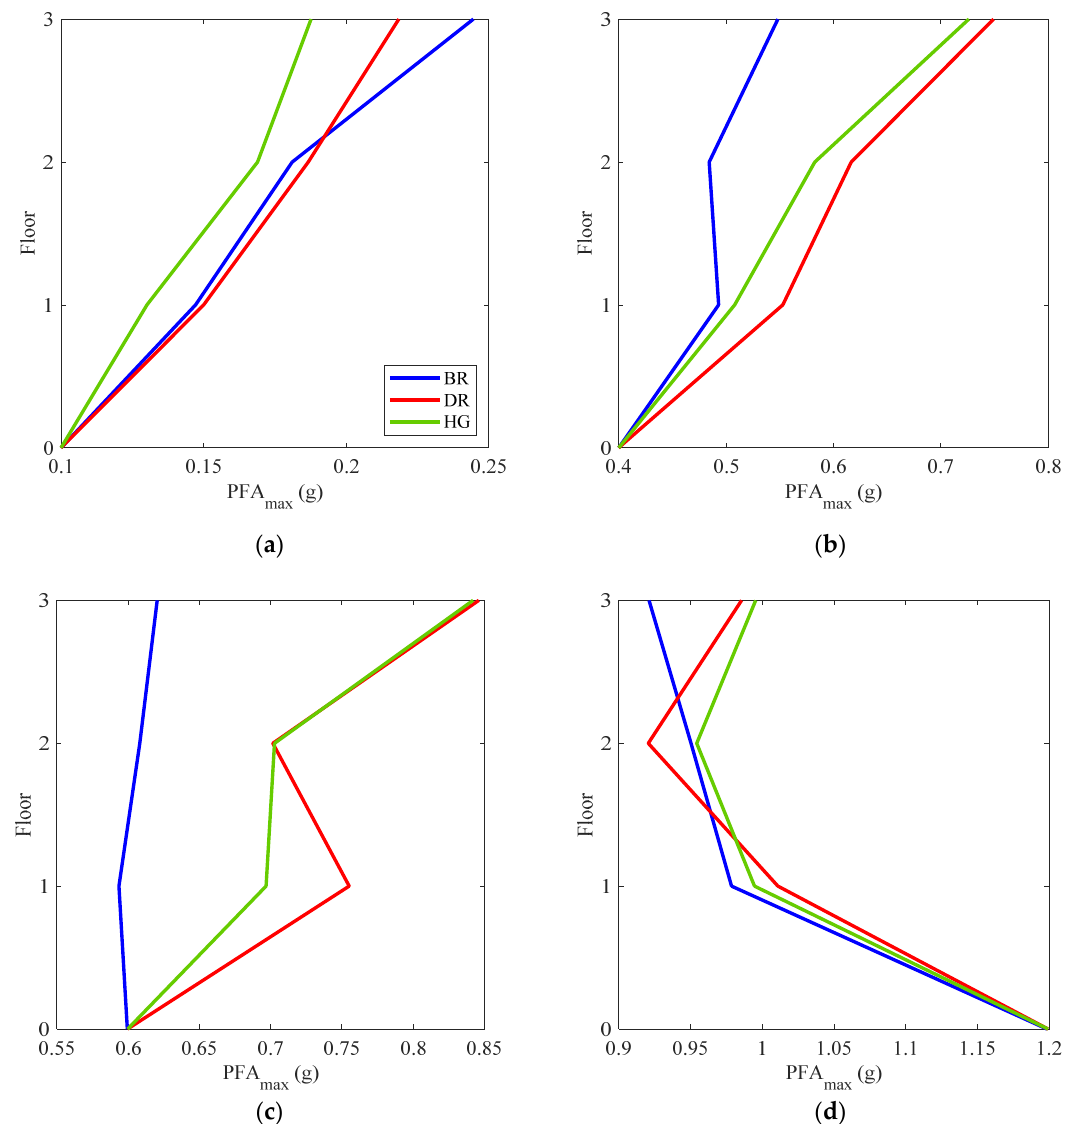
Figure 10. PFA profiles in the longitudinal direction for PGA corresponding to ( a ) 0.1 g, ( b ) 0.4 g, ( c ) 0.6 g, ( d ) 1.2